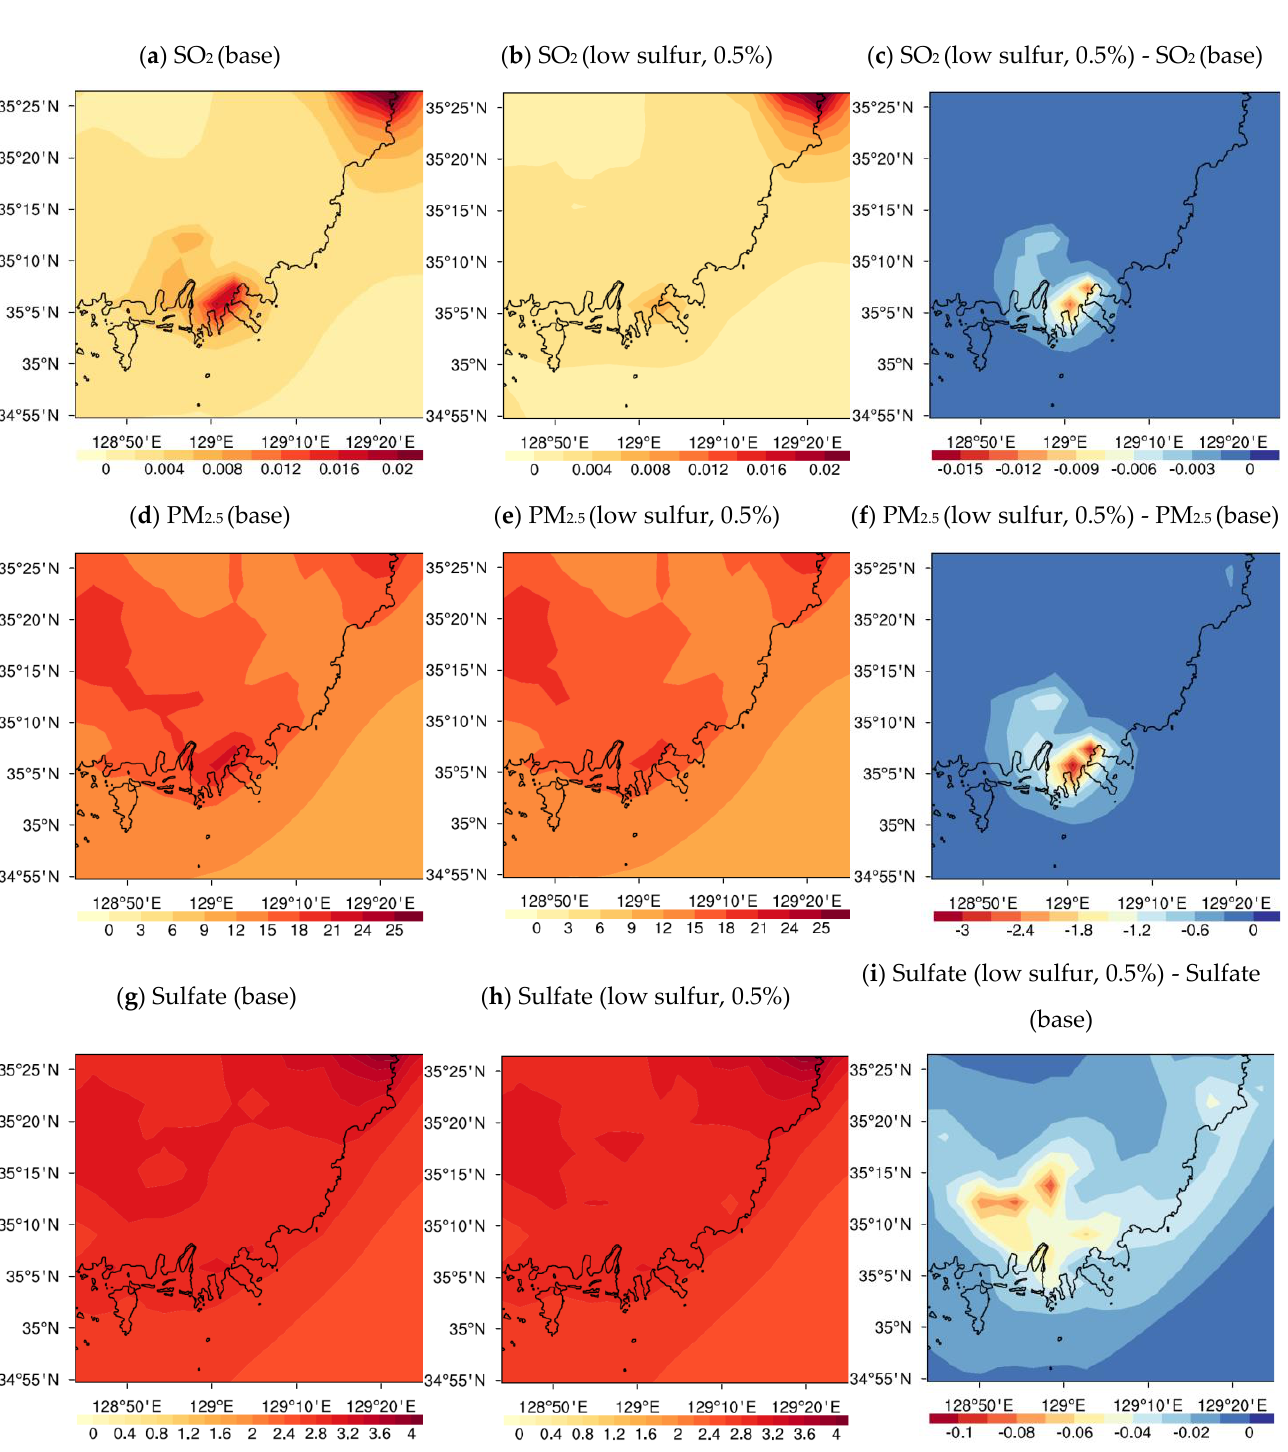
Figure 10. Concentration of SO 2 , PM 2.5 , and sulfate, respectively, for CAPSS2016 (base) and IMO2020 (low sulfur, 0.5%) applications and the difference in concentration for each.